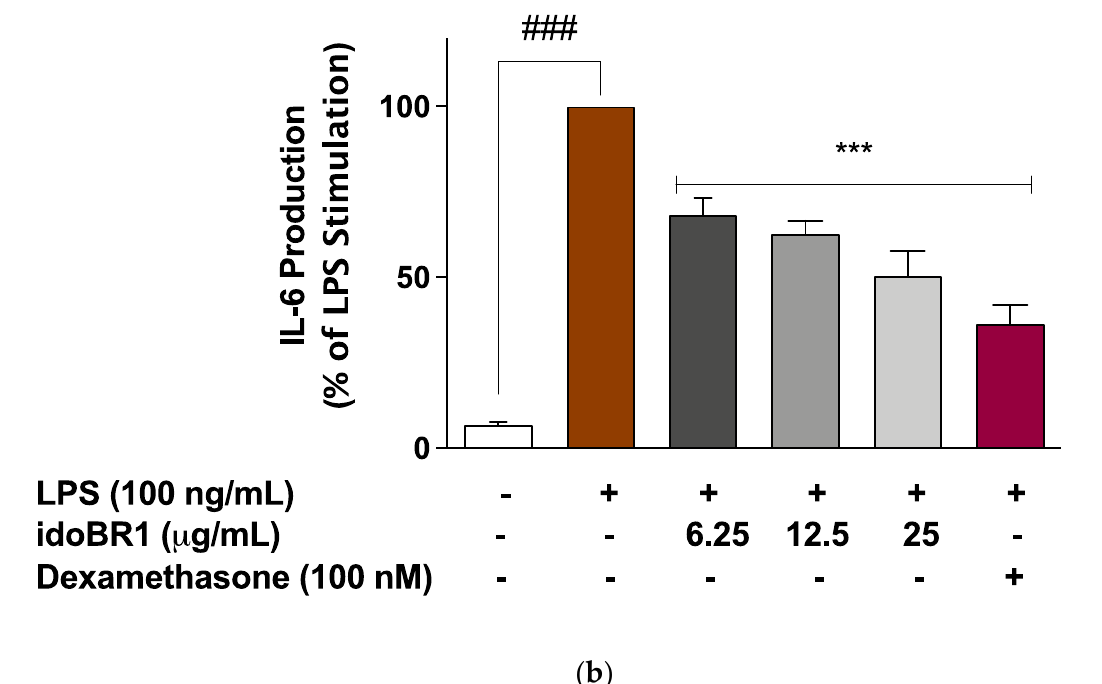
Figure 2. ( a ). Pre-treatment with idoBR1 (12.5 and 25 µg/mL) and dexamethasone (100 nM) reduced TNF α production in BV-2 microglia stimulated with LPS (100 ng/mL) for 24 h. TNF α production was evaluated in culture supernatants obtained from BV-2 microglia using mouse TNF α ELISA. All values are expressed as mean ± SEM for three independent experiments. Data were analyzed using one-way ANOVA for multiple comparisons with post hoc Student Newman–Keuls test. ns (not sig- nificant); *** p < 0.001 (treatment vs. LPS stimulation only); ### p < 0.001 (unstimulated cells vs. cells stimulated with LPS only). ( b ). Pre-treatment with idoBR1 (6.25, 12.5, and 25 µg/mL) and dexame- thasone (100 nM) reduced IL-6 production in BV-2 microglia stimulated with LPS (100 ng/mL) for 24 h. IL-6 production was evaluated in culture supernatants obtained from BV2 microglia using mouse IL-6 ELISA. All values are expressed as mean ± SEM for three independent experiments. Data were analyzed using one-way ANOVA for multiple comparisons with post hoc Student New- man–Keuls test. ns (not significant); *** p < 0.001 (treatment vs. LPS stimulation only); ### p < 0.001 (unstimulated cells vs. cells stimulated with LPS only).